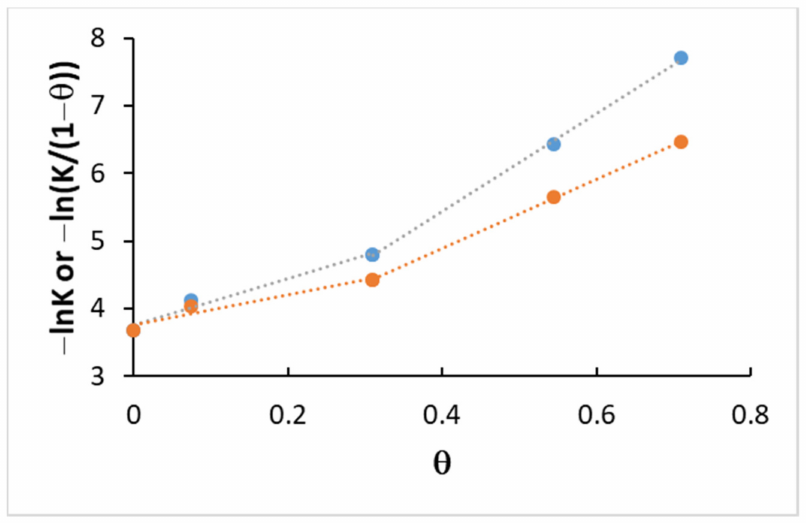
Figure 8. Plot of − lnK vs. θ (blue) and plot of − ln(K/(1 − θ )) vs. θ (orange), at E − Φ 2 = − 520